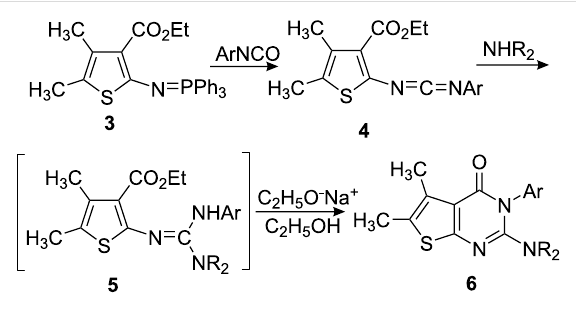
The reaction of carbodiimides 4 with primary amine RNH 2 in the presence of EtONa provided only 2-(alkylamino)-5,6- dimethylthieno[2,3- d ]pyrimidin-4(3 H )-ones 8 (Scheme 3),